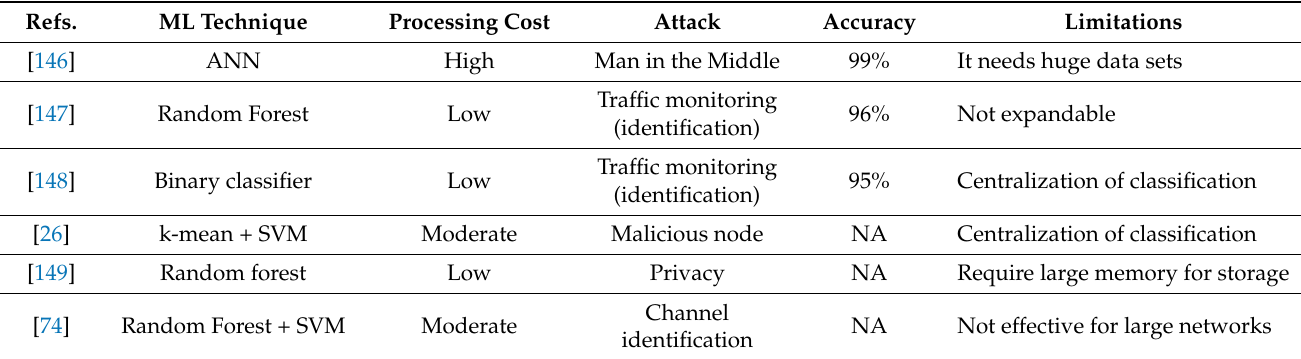
Table 8 provides an analysis of the reviewed studies in ML-based WSN diversified security. Table 8. Summary of reviewed ML algorithms in WSN diversified